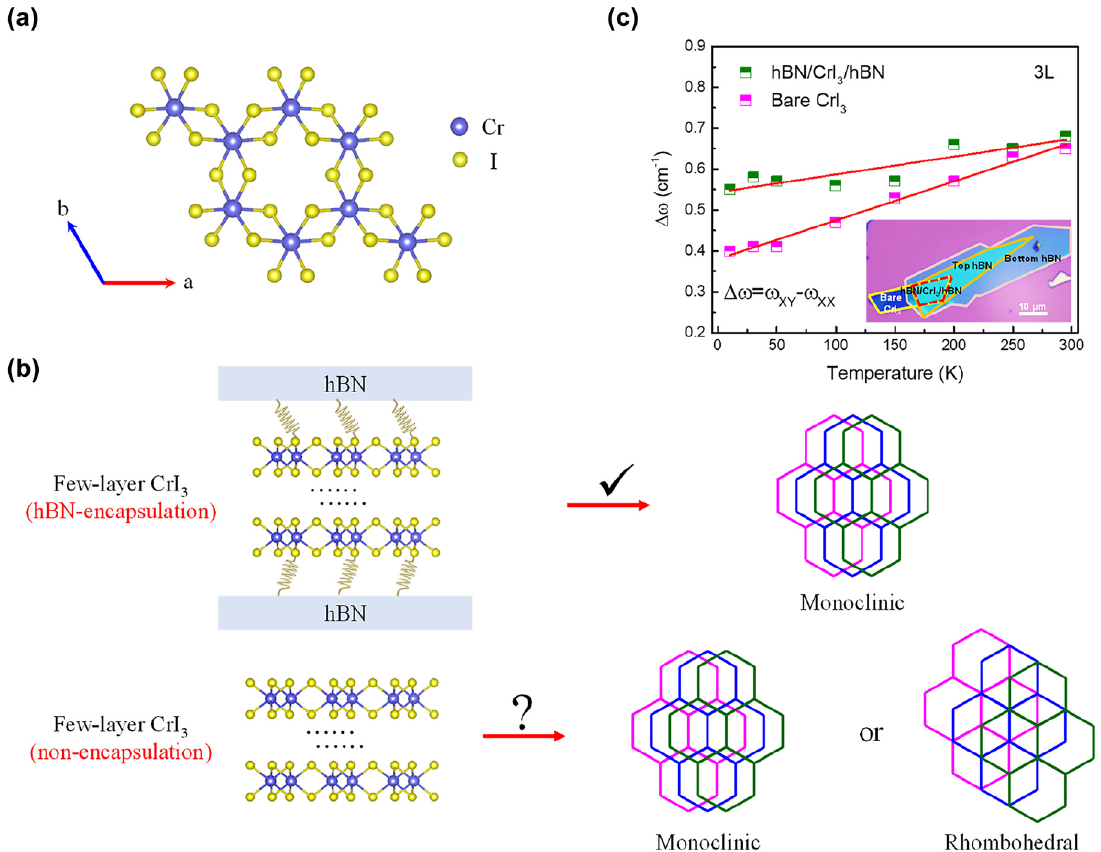
. (a) The in-plane atomic arrangement of monolayer CrI . The Cr atoms are Figure 1: Schematic of intrinsic structure of few-layer CrI 3 3 coordinated to six I atoms and the adjacent Cr atoms form a honeycomb structure. (b) The schematic of crystal structure between ferromagnet. The hBN-encapsulated few-layer CrI maintains monoclinic crystal structure through hBN-encapsulated and bare few-layer CrI 3 3 a spring damping effect, which has been hypothesized from the hBN-encapsulation layers, but so far, both this hypothesis and the crystal still remains elusive. (c) The Raman mode energy difference as a function of temperature in a half-bare and structure of bare few-layer CrI 3 . Inset is the optical image of a half-encapsulated and half-bare 3L CrI half-hBN-encapsulated 3L CrI 3 3